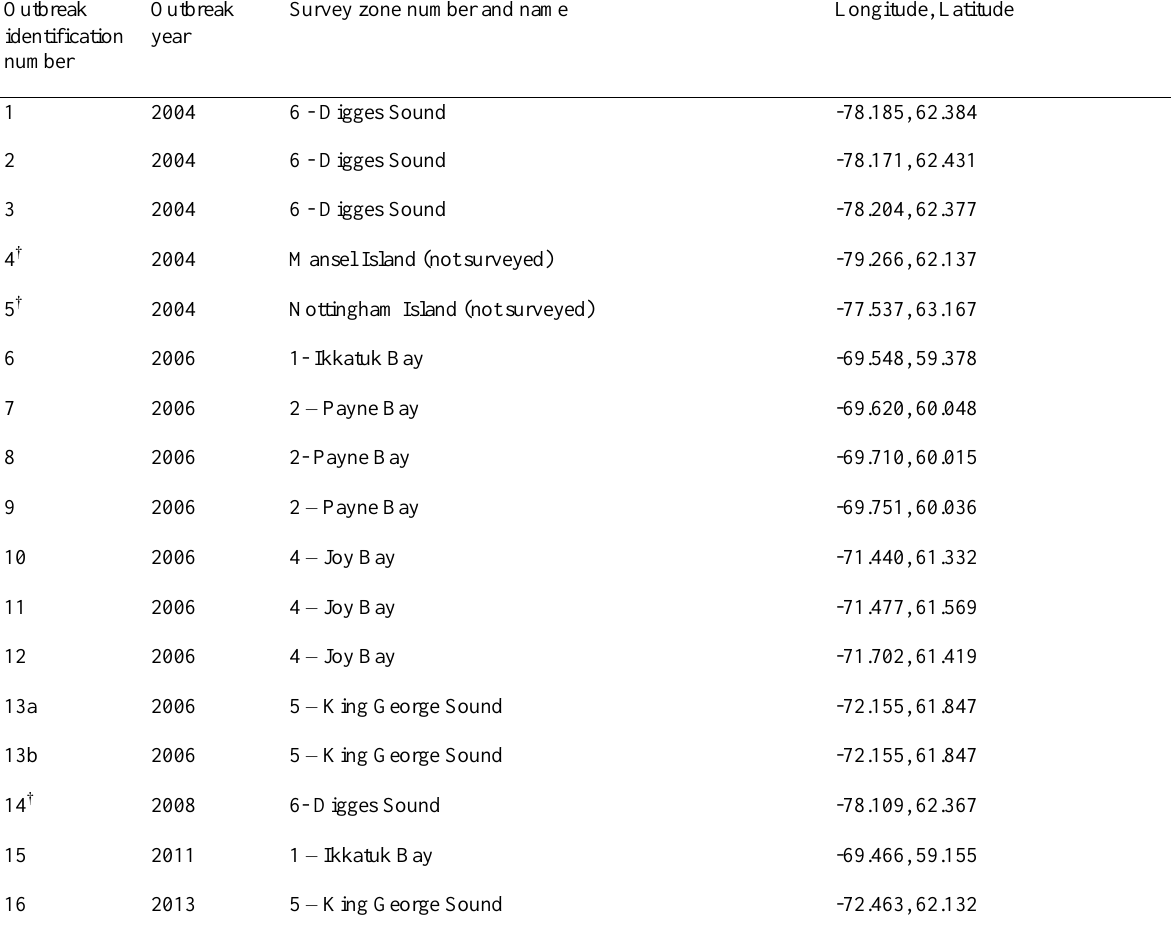
Table A1.2. Location of Avian Cholera outbreaks occurring on Northern Common Eider colonies in the Hudson Strait region of the Canadian Arctic between 2004 and 2013. Survey zone number and name correspond to areas identified in Figure 1. Outbreak identification number corresponds to mapped identification numbers provided in Figures A1.1 – A1.13. Outbreak identification numbers 13a and 13b refer to outbreaks occurring in multiple years at the same